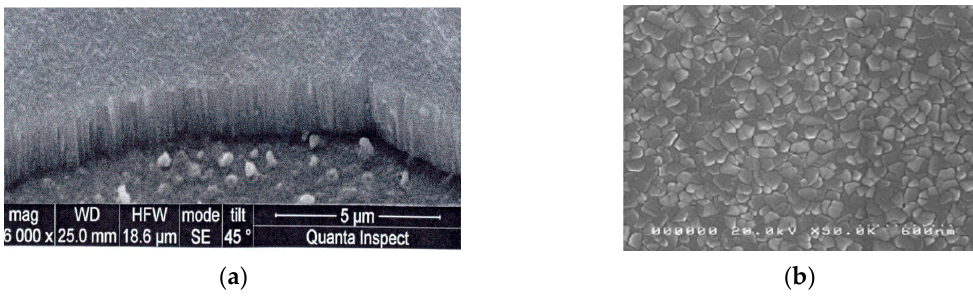
Figure 3. SEM images of PZT film: ( a ) side view of PZT film on Pt electrode; ( b ) PZT